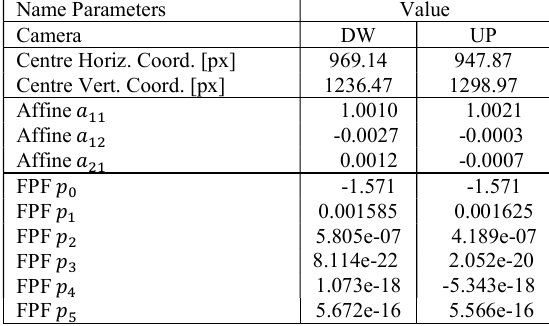
Table 3 Calibration results for direct model.